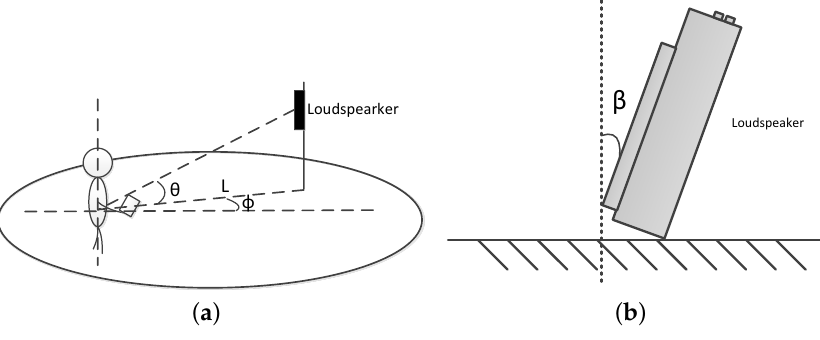
Figure 5. Experiment design. ( a ) the sketch of experiment design; and ( b ) the orientation angle β of the acoustic